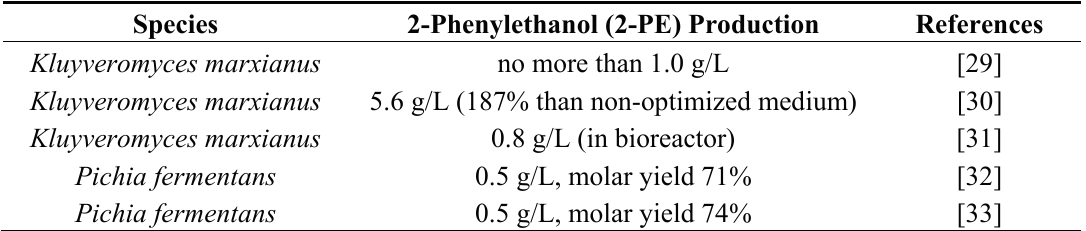
Table 1. Optimization of 2-phenylethanol (2-PE) production via biotransformations catalyzed by NCYs whole